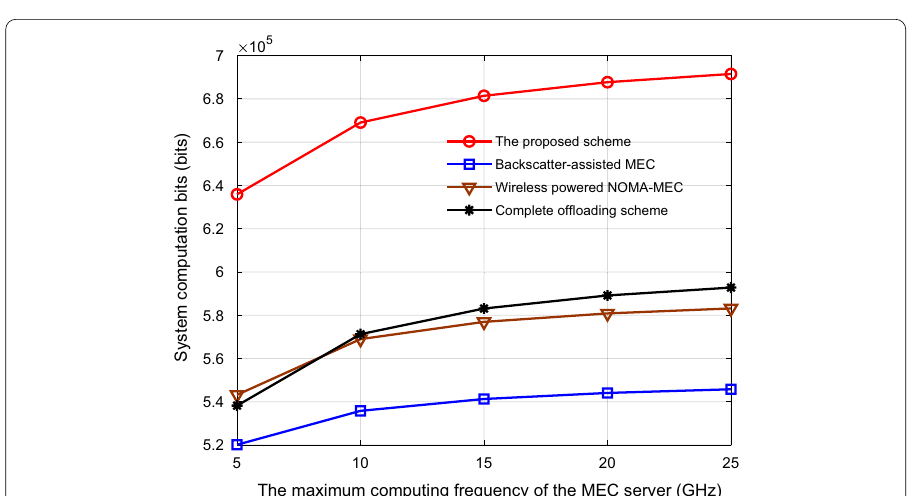
Fig. 5 System computation EE versus the maximum computing frequency at the MEC